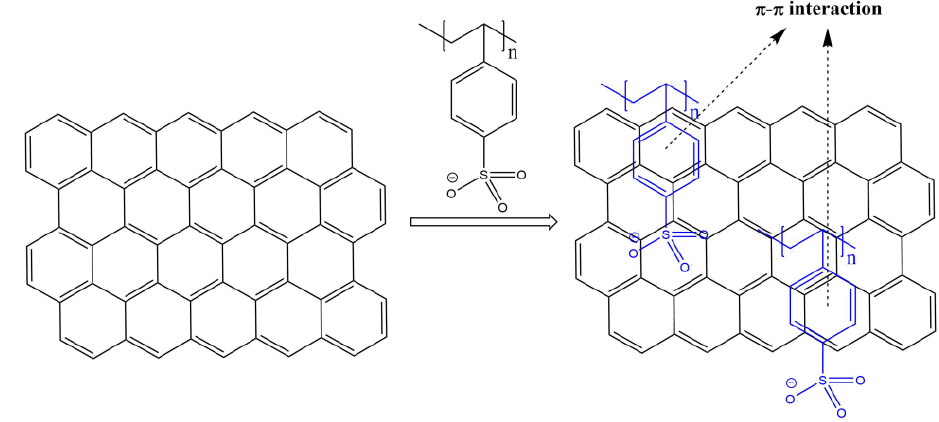
Figure 6. Schematic diagram of the reaction process.